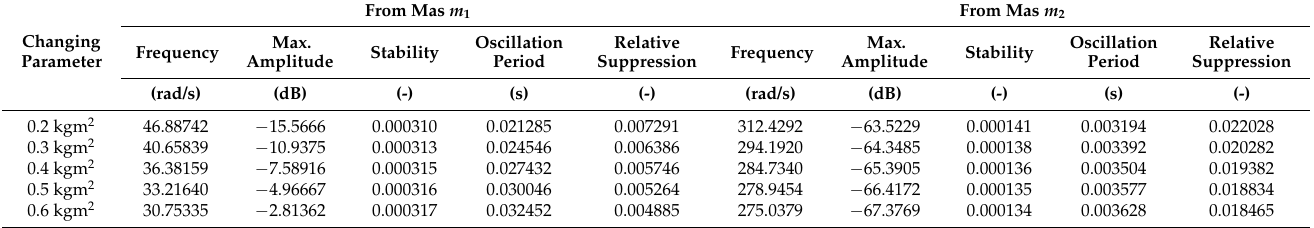
Table 1. The values of the parameters read from the graphs shown in Figure 7.